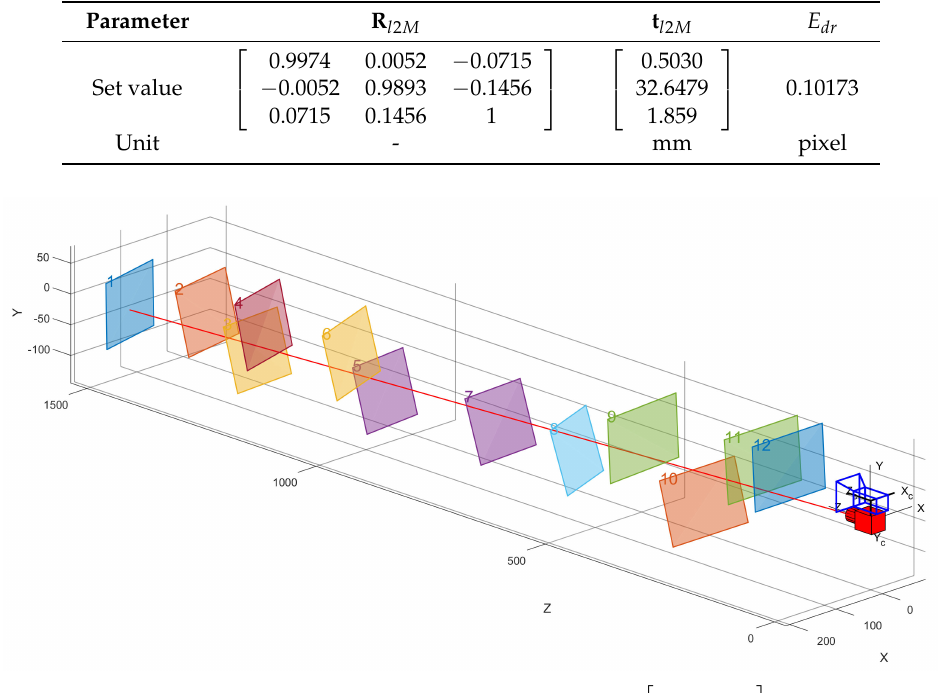
Figure 10. Visualization of extrinsic parameters